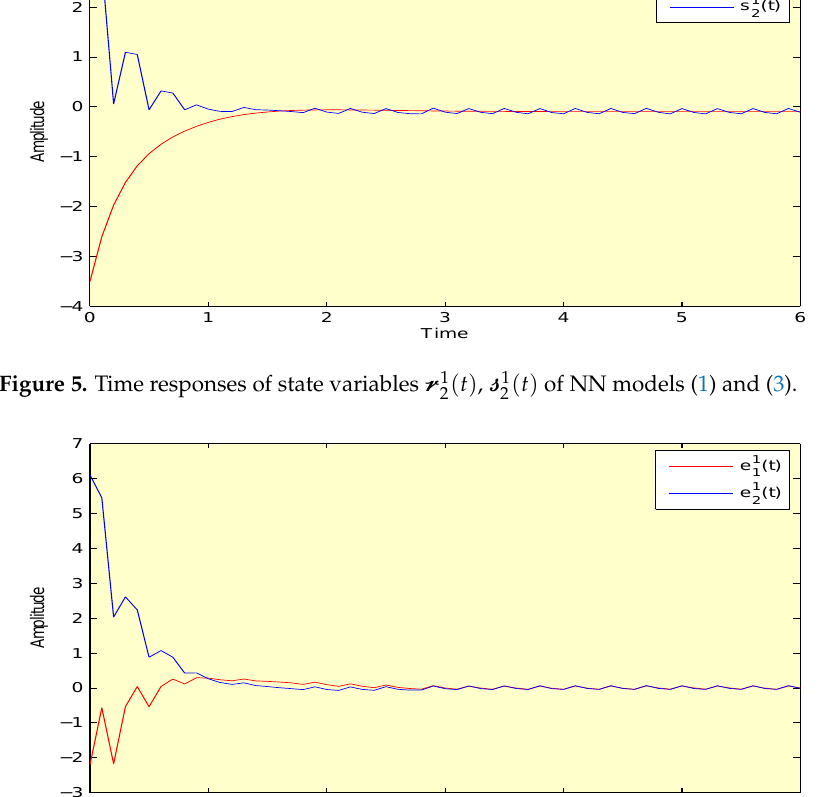
Figure 6. Synchronization curves of state variables (cid:101) 1 troller